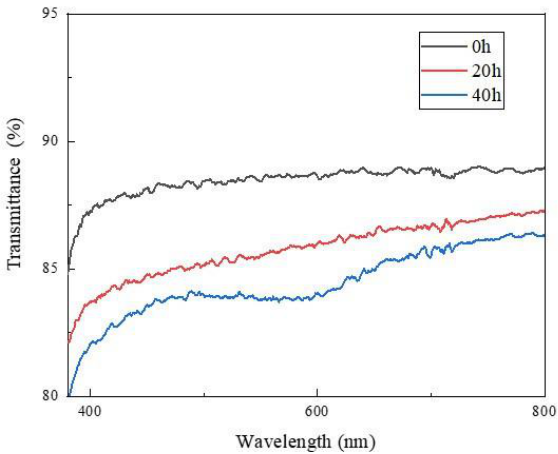
Figure 8. Visible light transmission spectra of S05 coatings with different scouring time.